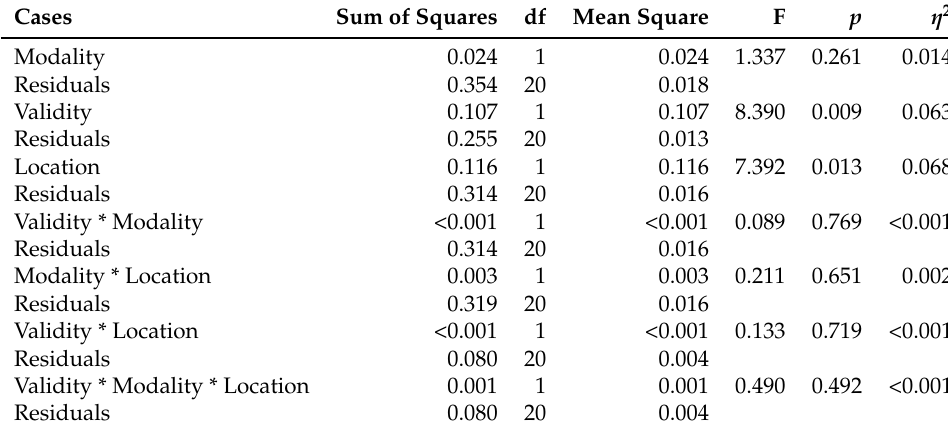
Table 3. Within subjects effects for Ammunition-Choice according to Predictivity (100, 50), Modality (visual, auditory), and Location (front, rear).